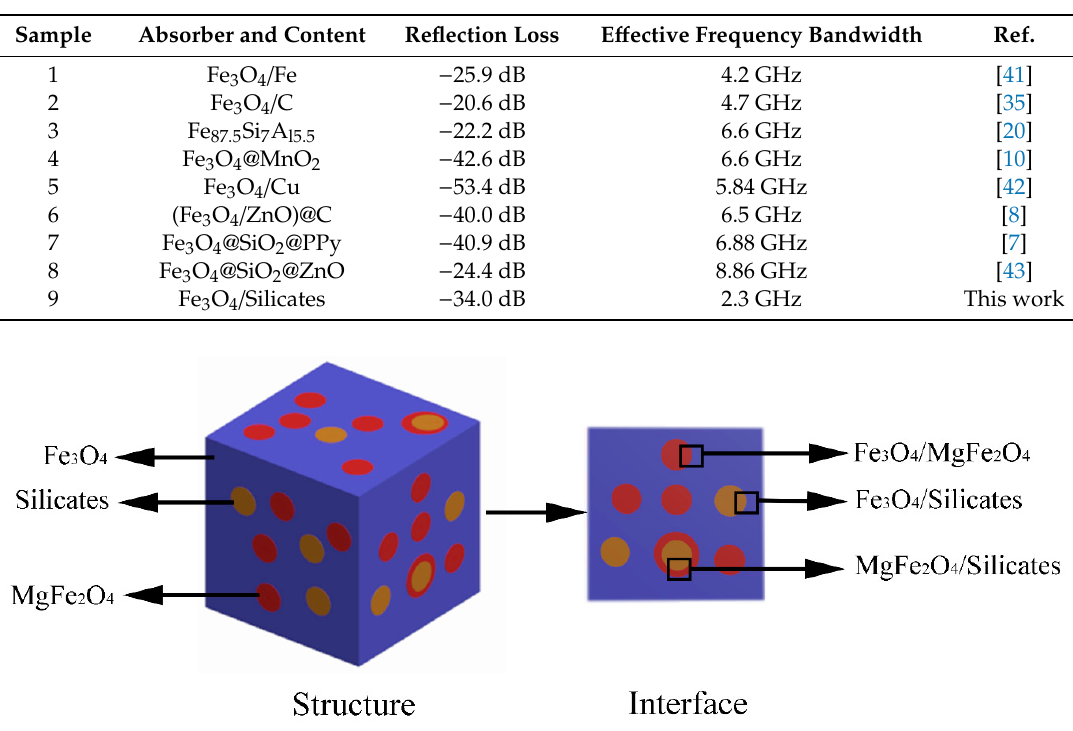
Figure 11. Schematic representation of the interface structure of MPs.